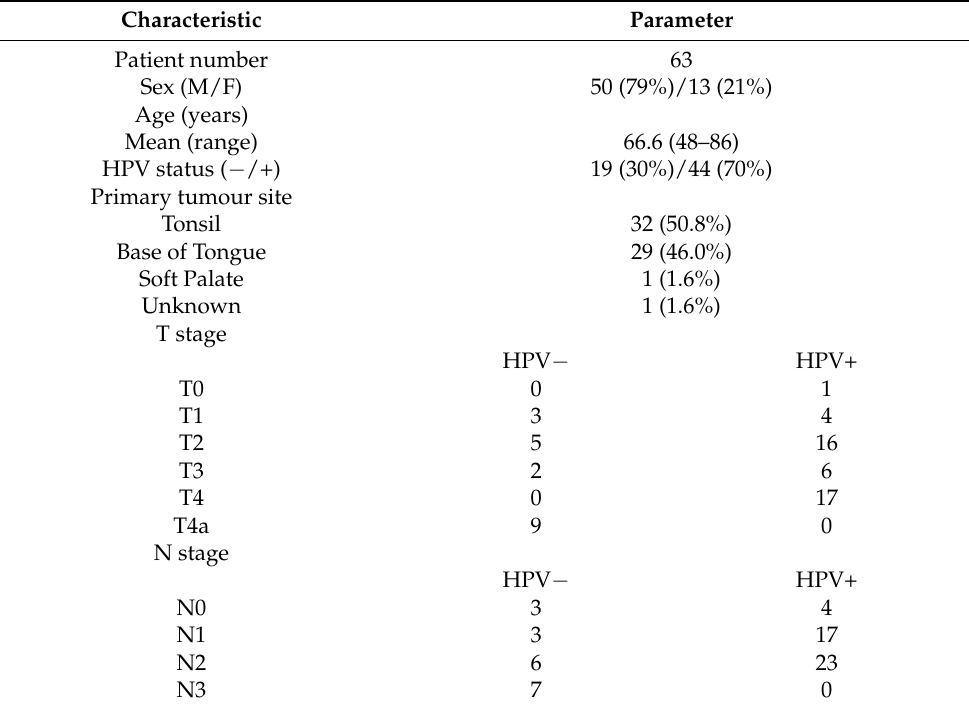
Table 1. Selected patient and tumour